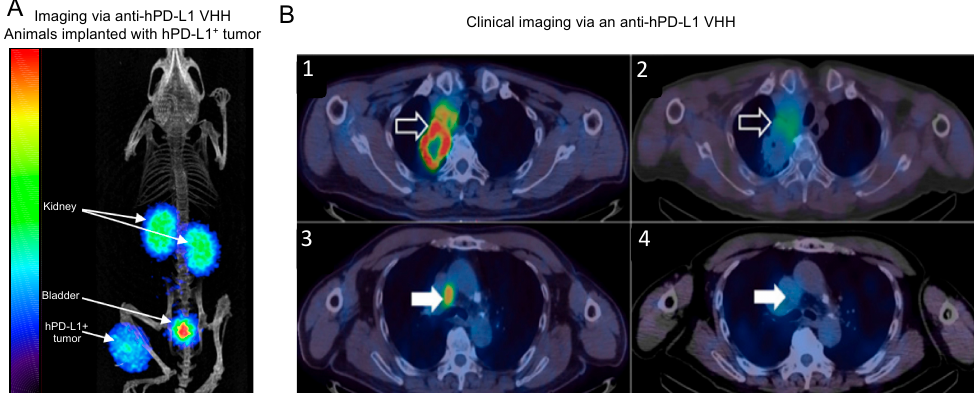
Figure 5. Imaging of checkpoint markers. ( A ) Imaging of human PD-L1. PET/CT imaging ~90 min p.i. of the 68 G-labeled anti-hPD-L1 VHH of a mouse bearing the hPD-L1 + tumor [94]. ( B ) Phase I study of 99m Tc-labeled anti-hPD-L1 VHH in non-small cell lung cancer patients [98]. The right upper lobe tumor ( 1 ) shows high [ 18 F]FDG uptake and ( 2 ) 99m Tc-VHH uptake within the tumor. A mediastinal lymph node showed high [ 18 F]FDG uptake ( 3 ), however low 99m Tc-VHH uptake was observed ( 4 ), suggesting PD-L1 is heterogeneously expressed between the primary tumor site and distant sites of disease within the same patient.